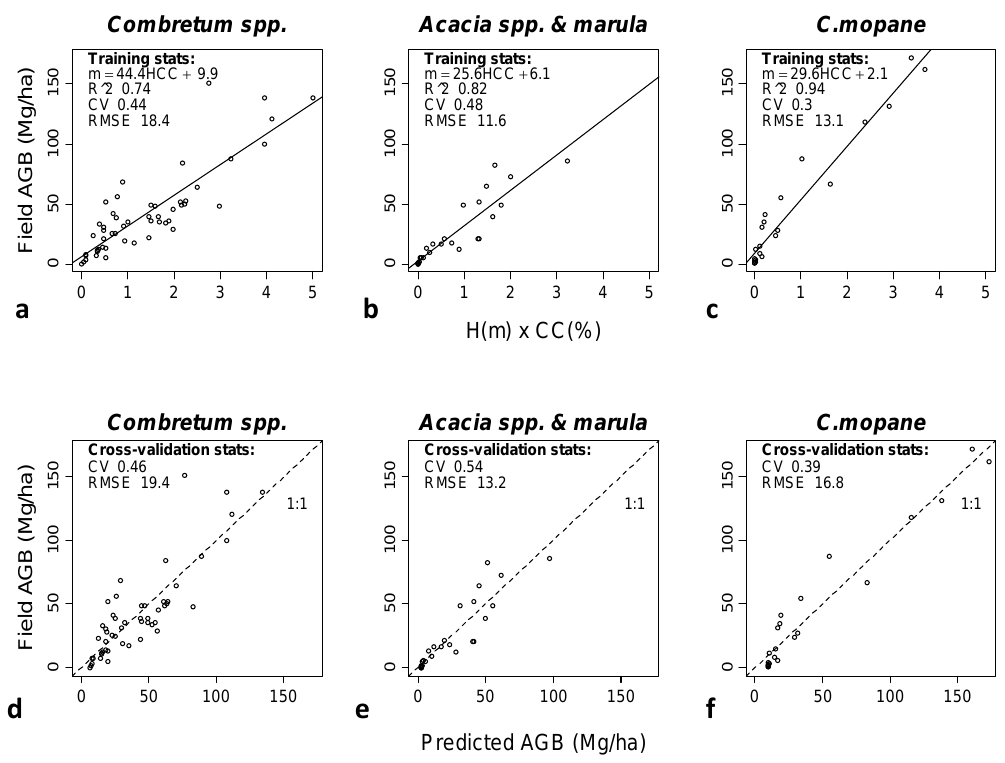
Fig. 2. Model calibration and cross-validation to predict AGB using airborne LiDAR. Points represent calibration field plots. Three models were trained according to dominant woody species: (a) mixed broadleaf ( Combretum apiculatum, Combretum collinum) and fineleaf ( Acacia nigrescens, Dichrostachys cinerea) savanna (b) Acacia spp. and marula ( Sclerocarya birrea) savanna (c) mopane ( Colophospermum mopane ) savanna. (d–f) Observed AGB vs. predicted AGB with test RMSE and coefficient of variation (CV) estimated using k -fold cross-validation ( k